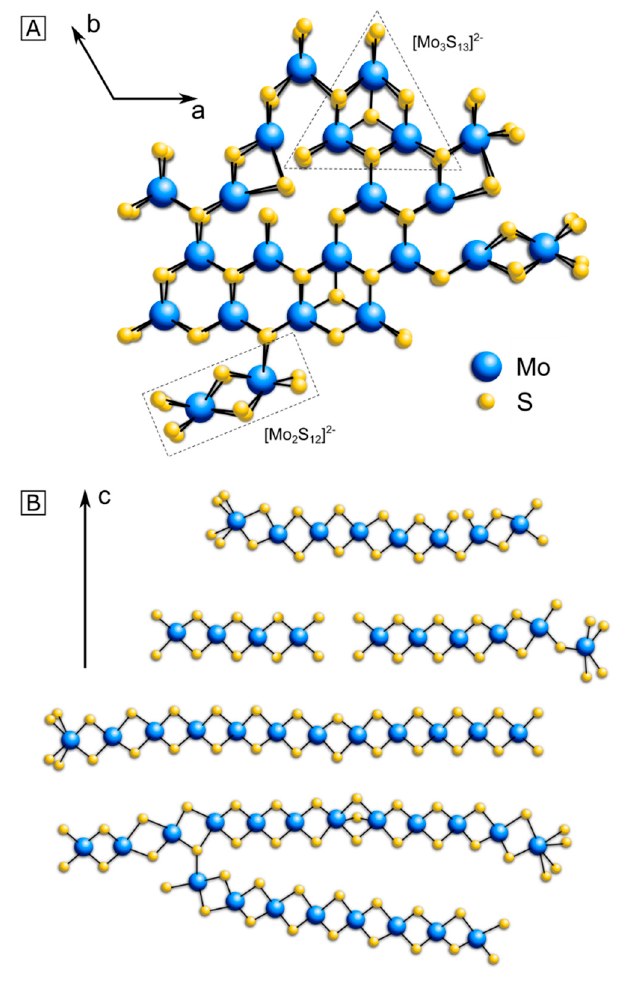
Figure 7. Schematic illustration of the suggested structure model for MoS 2 + δ . The indicated a-, b- and c-axis represent the unit cell and lattice parameters of MoS 2 . ( A ): plane view; ( B ): out of plane view. Table 3. Mo-Mo distance of MoS 2+ δ compared with MoS 2 [30] and the cluster anions [Mo 2 S 12 ] 2 − and [Mo 3 S 13 ] 2 − [18].